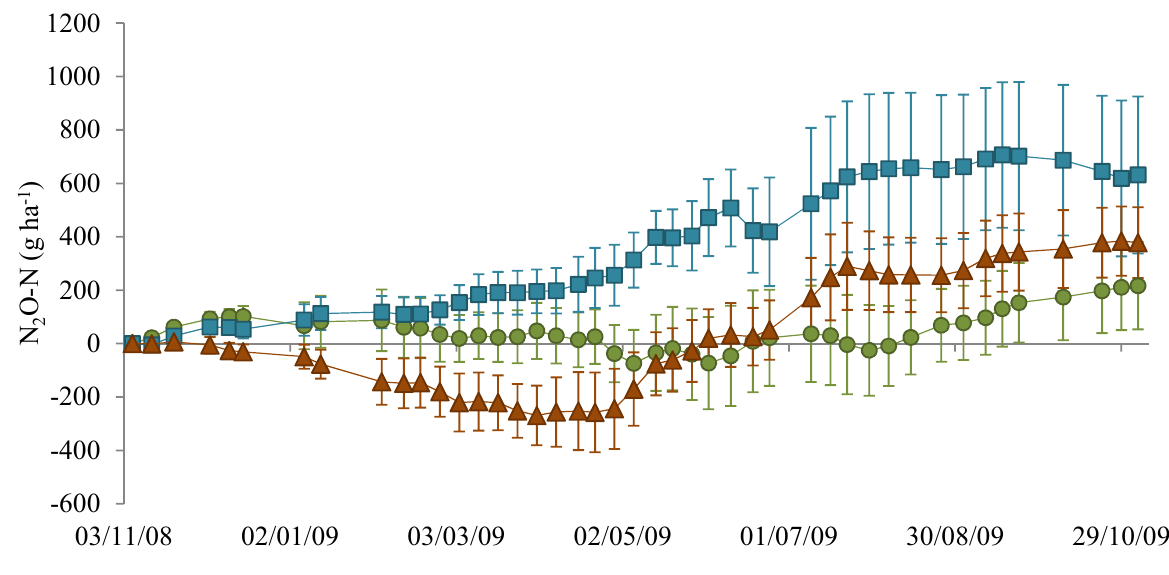
Figure 3. Cumulative N O Flux (g·N·ha − 1 ) ± SE (n = 8) over one year from three land 2 uses; G ( ● ), NM ( ■ ) and EM ( ▲